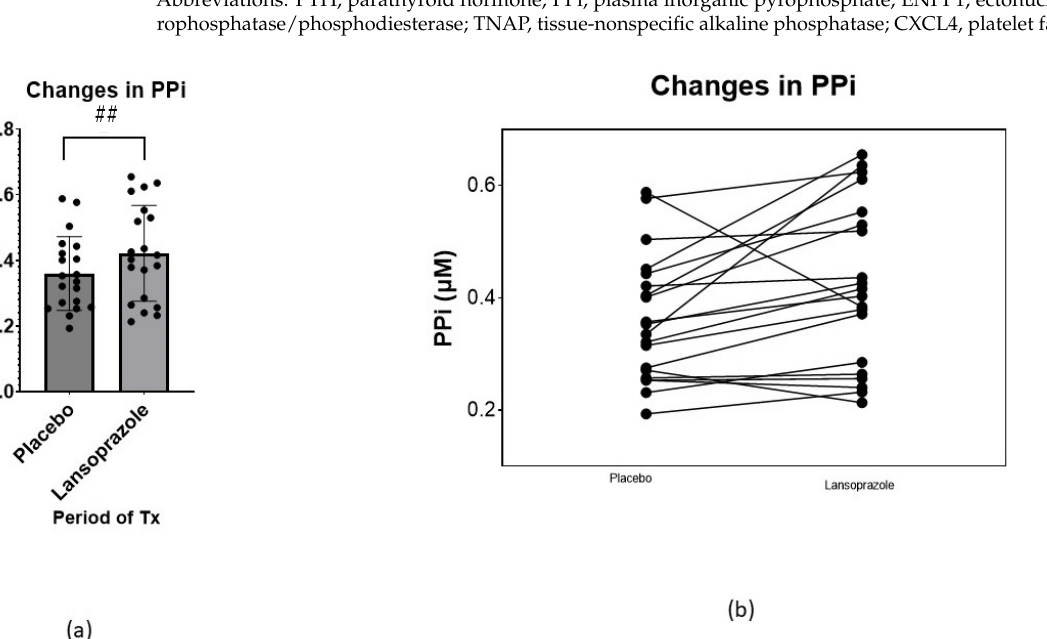
Figure 3. Individual percentage changes in PPi, comparing the end of the placebo phase and the end of the lansoprazole phase. 20.2% (2.7–31.5%). 3. We observed six adverse events during the trial (Table S4 in Supplementary Mate- rial); in only one case did the patient drop out from the study due to the adverse event. 3. Discussion Our trial shows that administration of lansoprazole 30 mg increased PPi levels in patients with PXE compared with the placebo in a short period of 8 weeks. Because PPi is